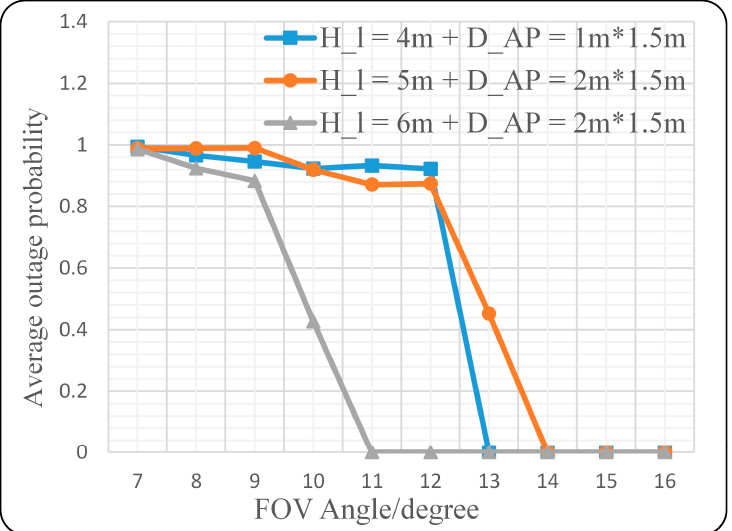
Figure 15. The average outage probability under different FOV angles of receiver.